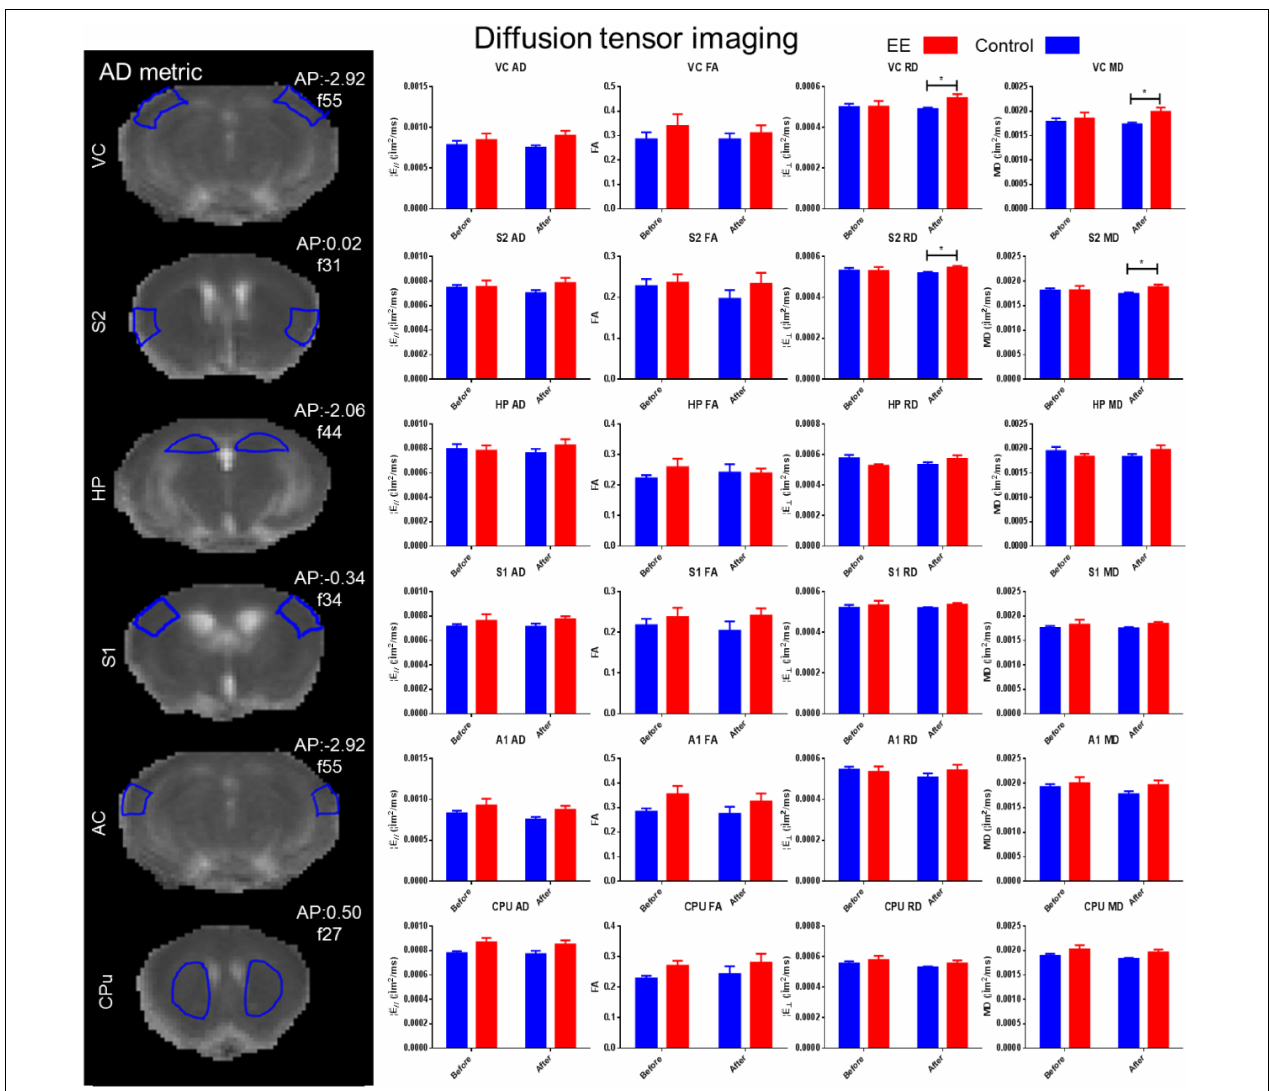
FIGURE 3 | DTI alterations in environmental enrichment. DTI was measured by AD, FA, RD, and MD. There was a significant increase in RD and MD in the visual cortex and secondary somatosensory cortex in the after-EE time point ( t -test, p < 0.05). DTI metrics were assessed in the hippocampus (HP: Bregma –2.06 mm), visual cortex (VC: Bregma –2.92 mm), auditory cortex (AC: Bregma –2.92 mm), the primary somatosensory cortex (S1: Bregma –0.34 mm), and secondary somatosensory cortex (S2: Bregma 0.02 mm), and the caudate putamen (CPu; Bregma 0.50 mm) were all measured in the EE and SE controls for both time